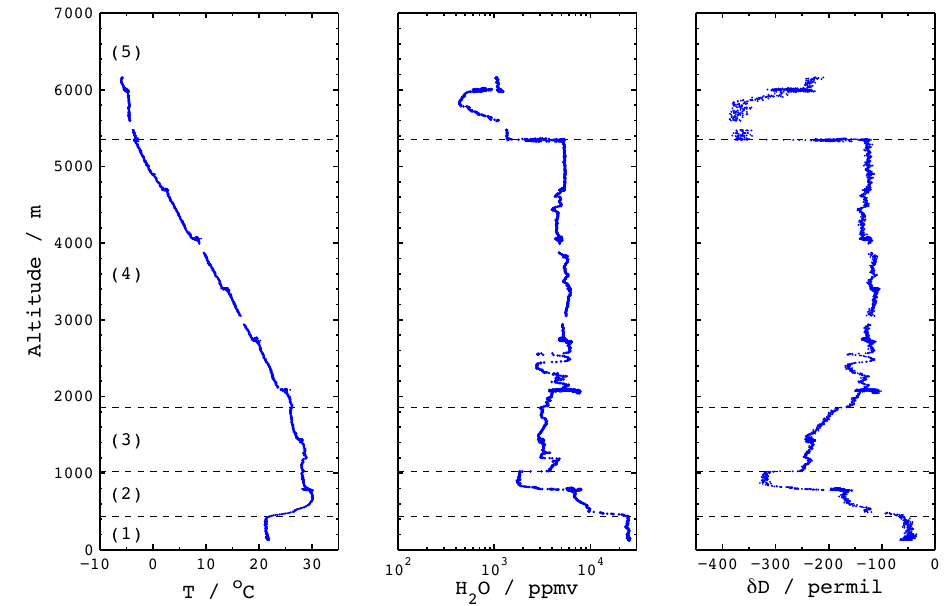
Figure 10. Measurements of temperature ( T ), H 2 O mixing ratio, and δ D taken with 1s averaging on 31 July 2013. The profile is divided into five layers for